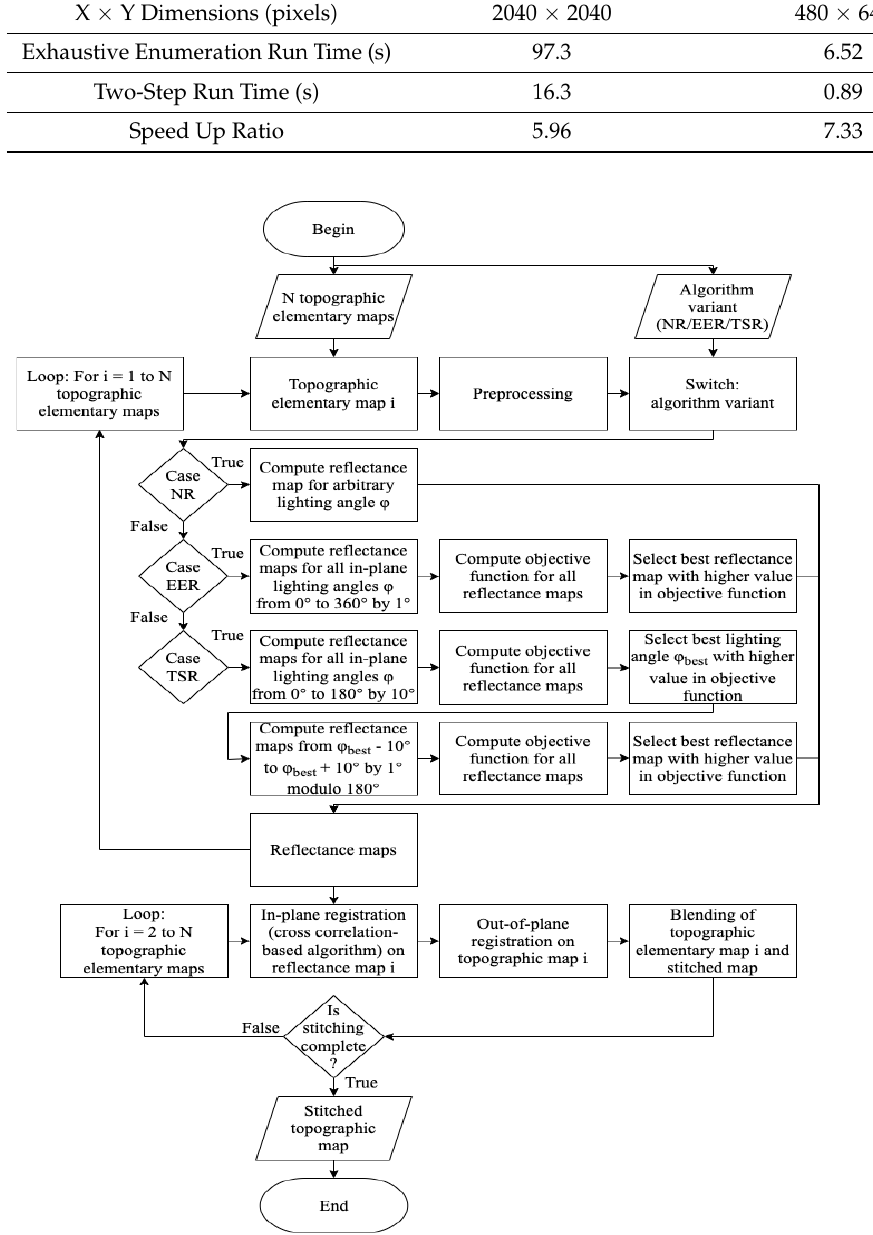
Table 3. Run time comparison between exhaustive enumeration and two-step reflectance algorithms for two types of topography.